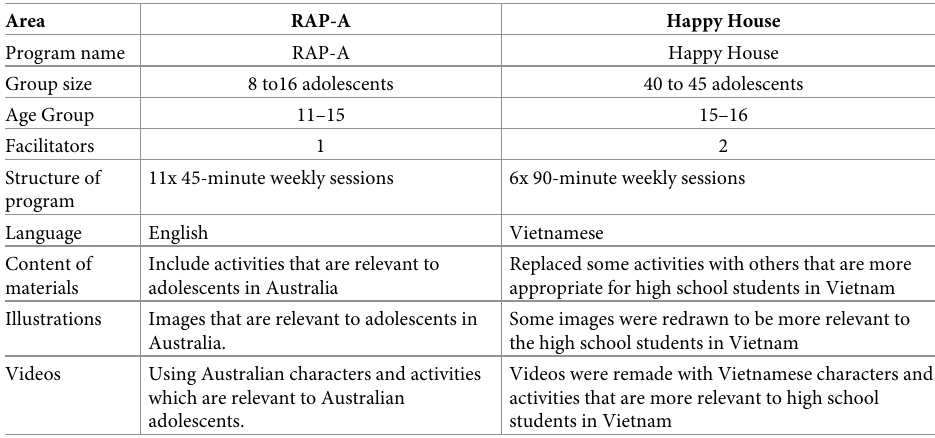
Table 1. Summary of the changes in Happy